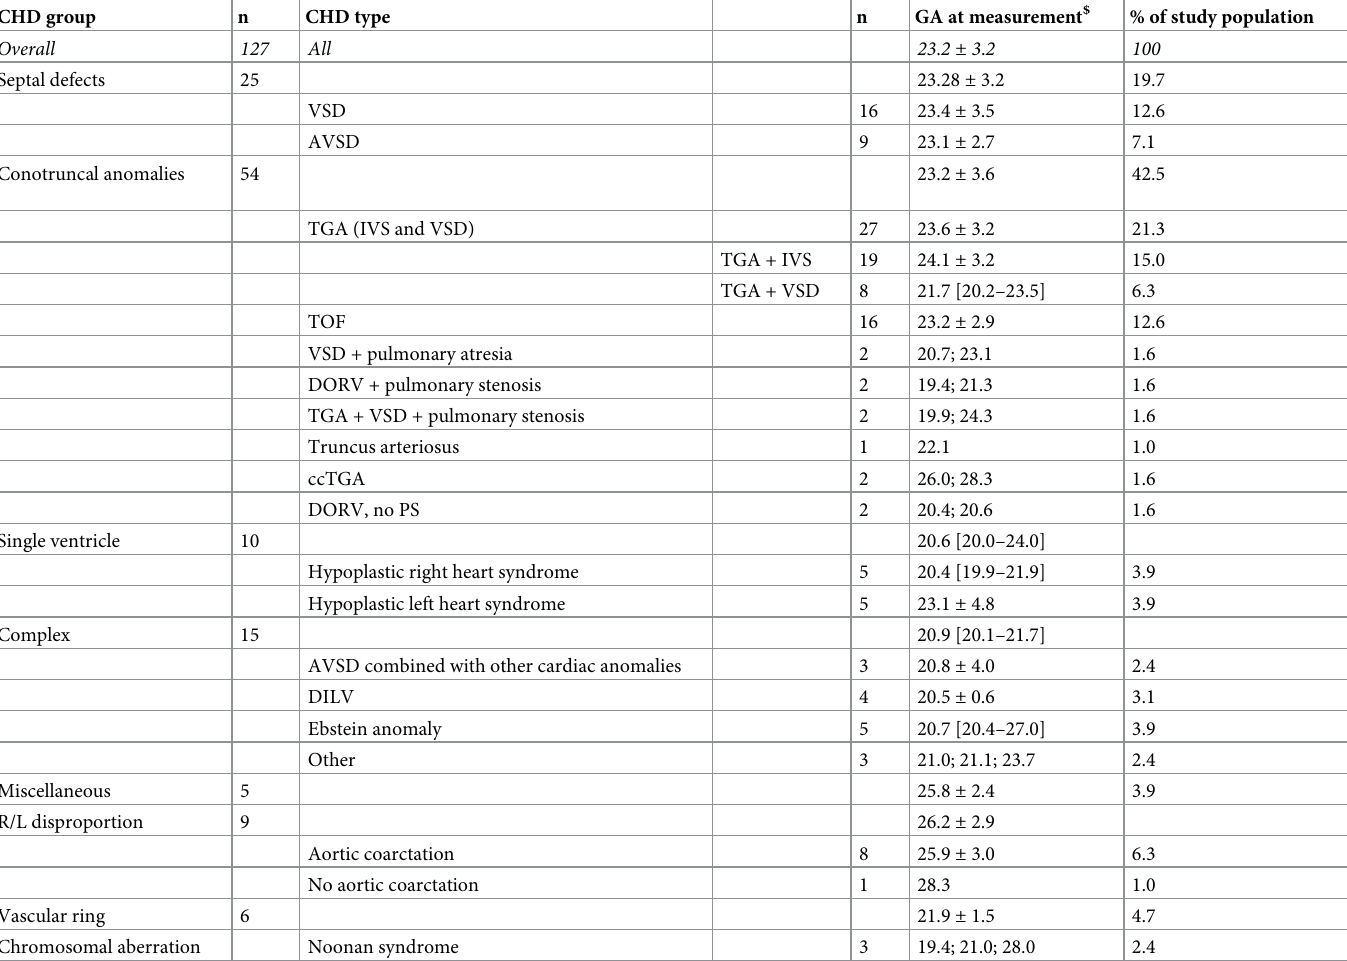
Table 1. Distribution of the different types of CHD included in the study